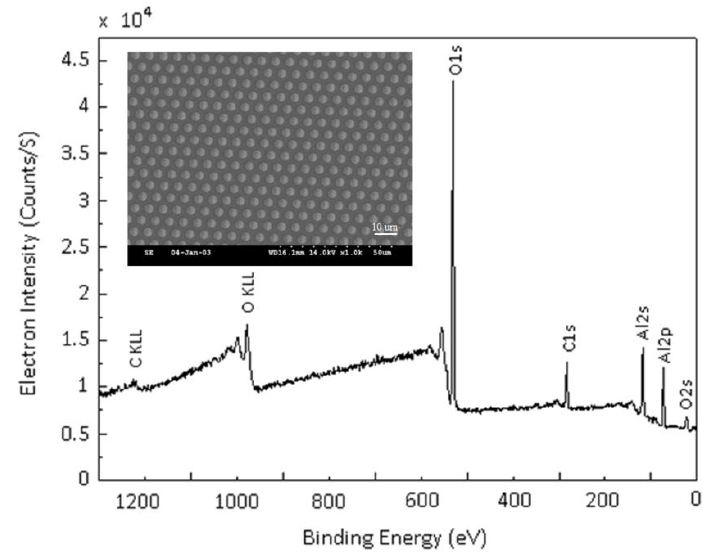
Figure 5. Photoelectron spectrum of GaN-epi/PSS prepared with a gas-flow rate of 25 sccm for 90 min followed by wet etching.